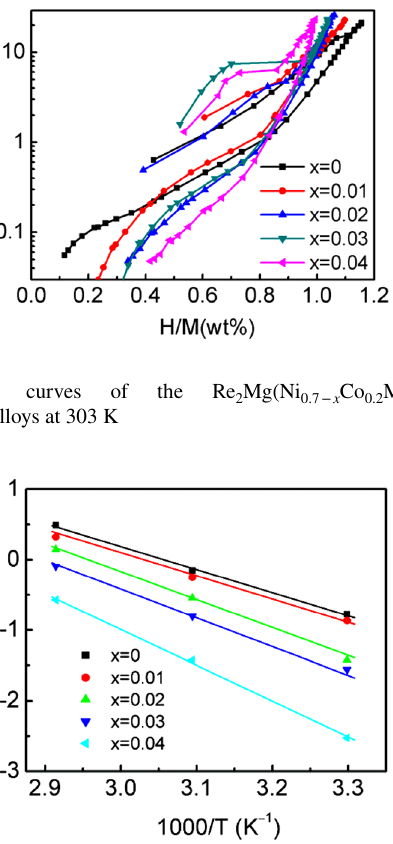
Fig. 5 Van’t Hoff plots for hydrogen desorption of Re x = 0 ‒ 0.04)alloys .2 Mn 0.1 Al x ) 9 (